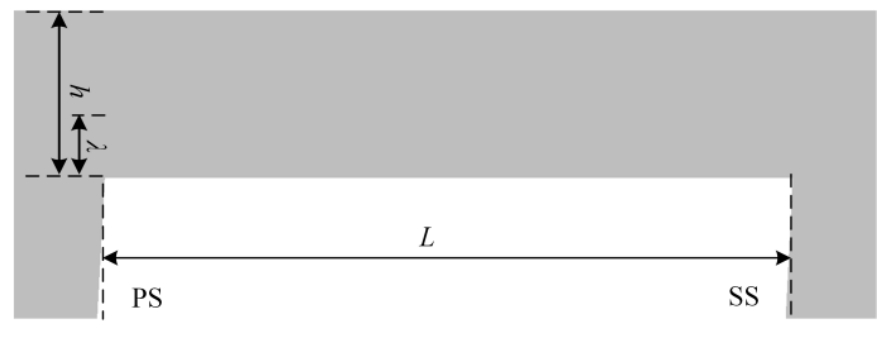
Figure 16. Schematic of the tip clearance .